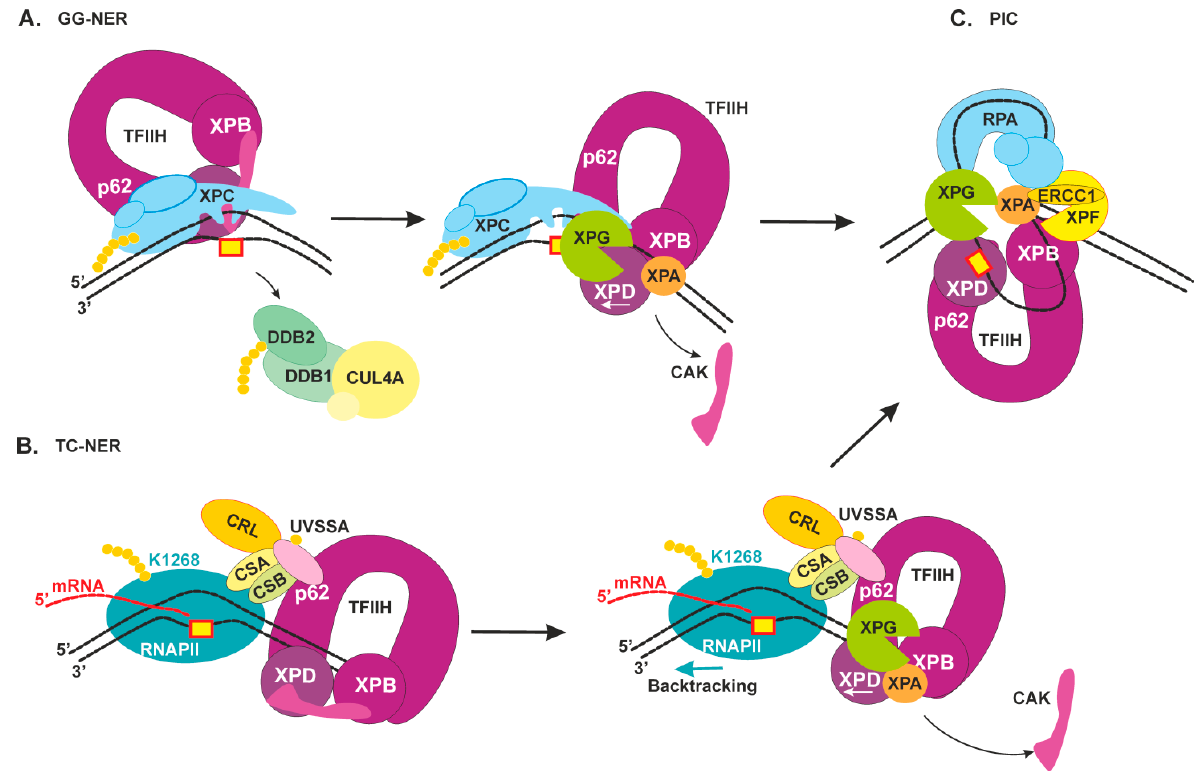
Figure 3. Schematic view of the damage verification step of NER and pre-incision complex formation. ( A ) GG-NER. TFIIH initially interacts with XPC’s N terminus by means of p62 subunits, then tumbles to XPC’s C terminus, where the interaction with XPB promotes its binding to a duplex part. XPA releases an inhibitory CAK module and together with XPG stimulates XPD activity [45]. The XPD helicase binds to the damaged strand and starts to a repair bubble formation [7]. When XPD gets to the lesion and stalls on it, XPC is displaced, and XPG binds to the 3 ′ edge of the repair bubble. ( B ) TC-NER. XPC and UVSSA share an interaction surface on the p62 subunit of TFIIH [41]. RNAPII moves in the 3 ′ → 5 ′ di- rection on the damaged strand, then, after its lesion stalling and assembly of factors CSB, CSA, and UVSSA, the latter promotes TFIIH binding downstream of RNAPII [37]. Thereafter, XPA and XPG stimulate XPD activity, and TFIIH starts to move in the 5 ′ → 3 ′ direction and may “push” RNAPII for a backtracking movement. ( C) The NER pre-incision complex (PIC): TFIIH stalls on the lesion-bearing strand, RPA covers the undamaged strand, XPA marks the 5 ′ edge of the repair bubble, XPG marks the 3 ′ edge of the repair bubble, and XPF–ERCC1 binds behind XPA.